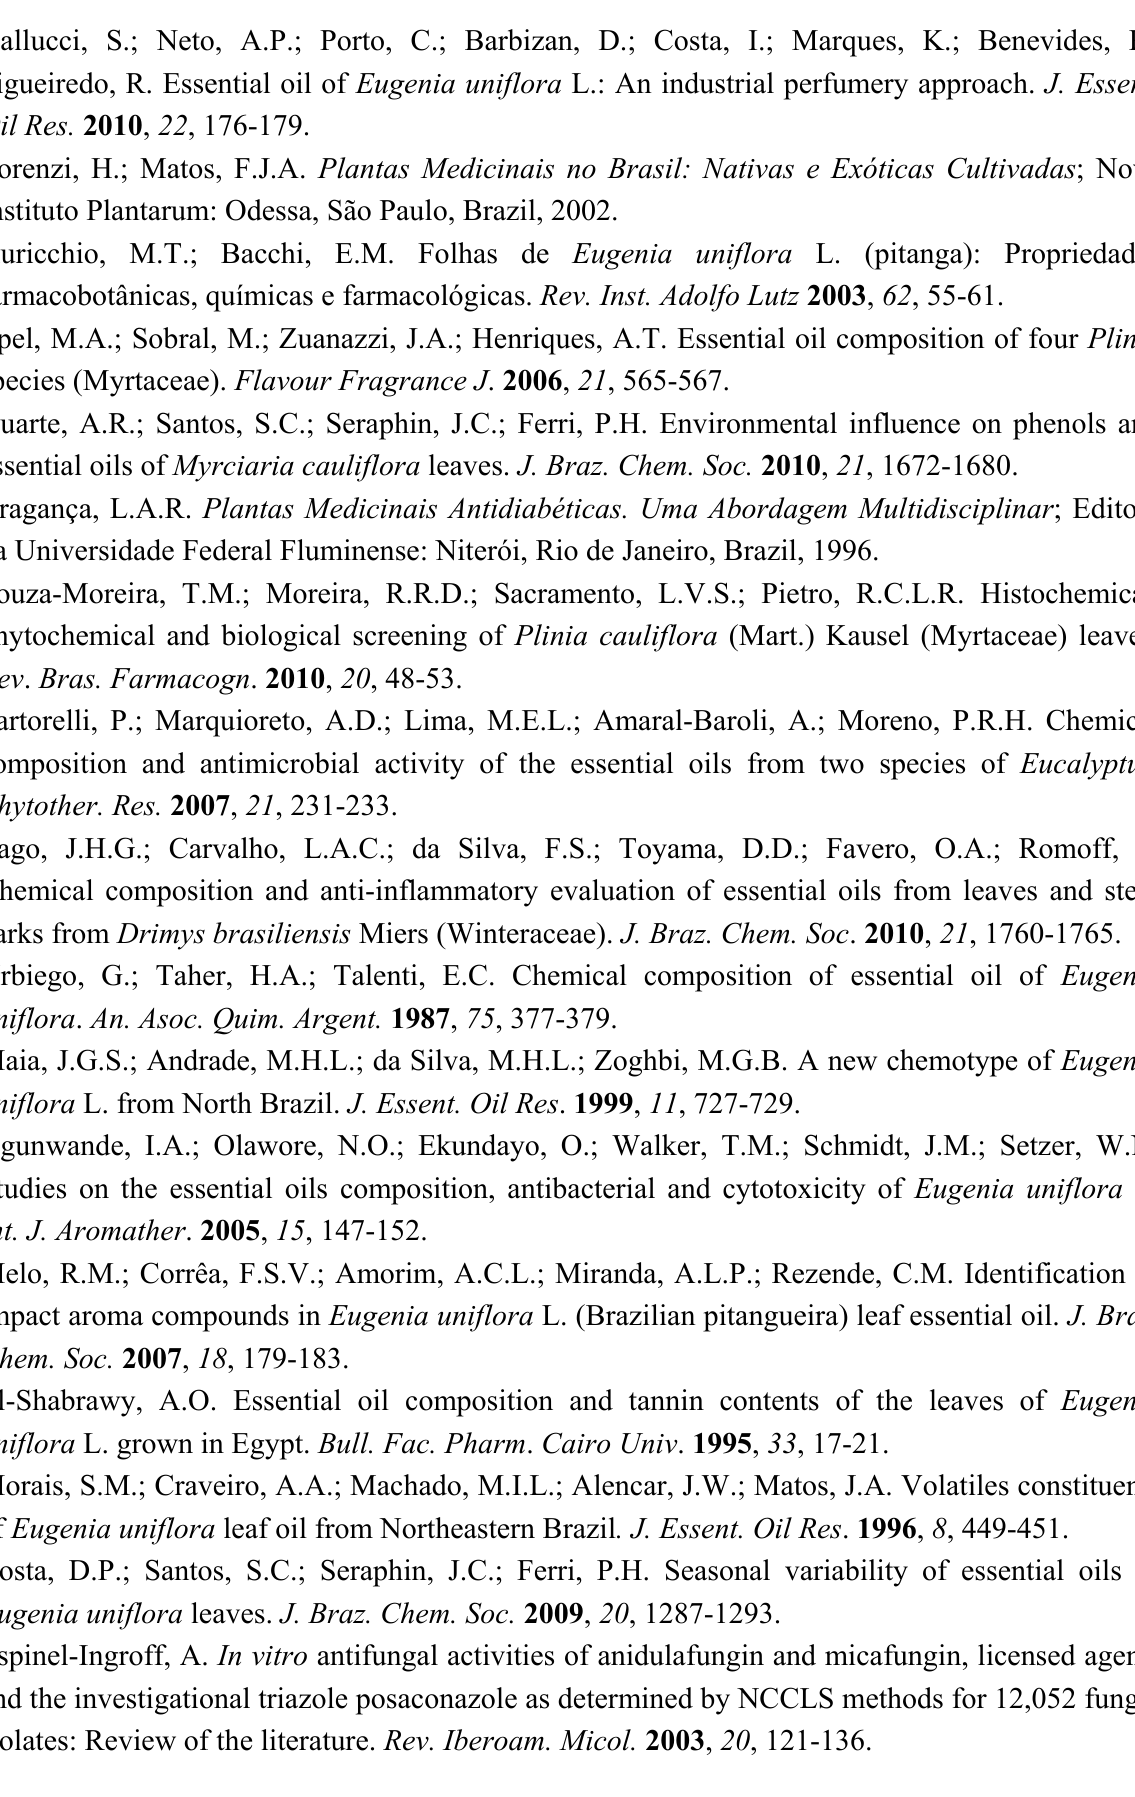
Figueiredo, R. Essential oil of Eugenia uniflora L.: An industrial perfumery approach. J. Essent. Oil Res. 2010 , 22 ,